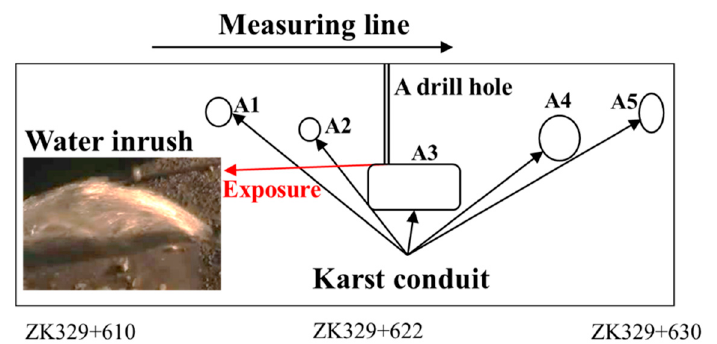
Figure 9. GPR recognition of the geology below the tunnel floor and the actual situation of water inrush from the drill hole [14].